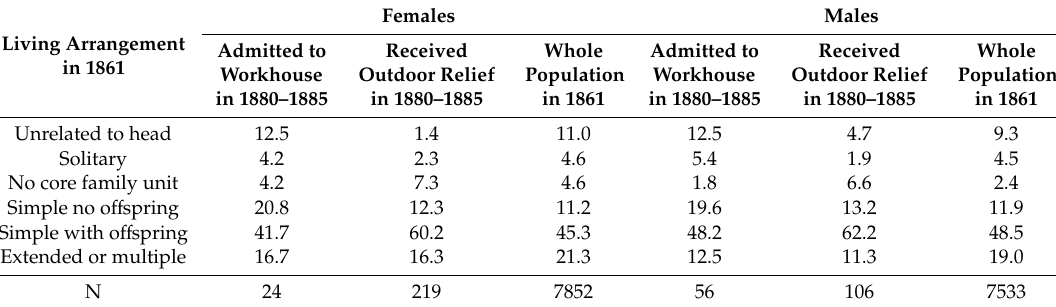
Table 4. Percentages with various living arrangements in 1861.